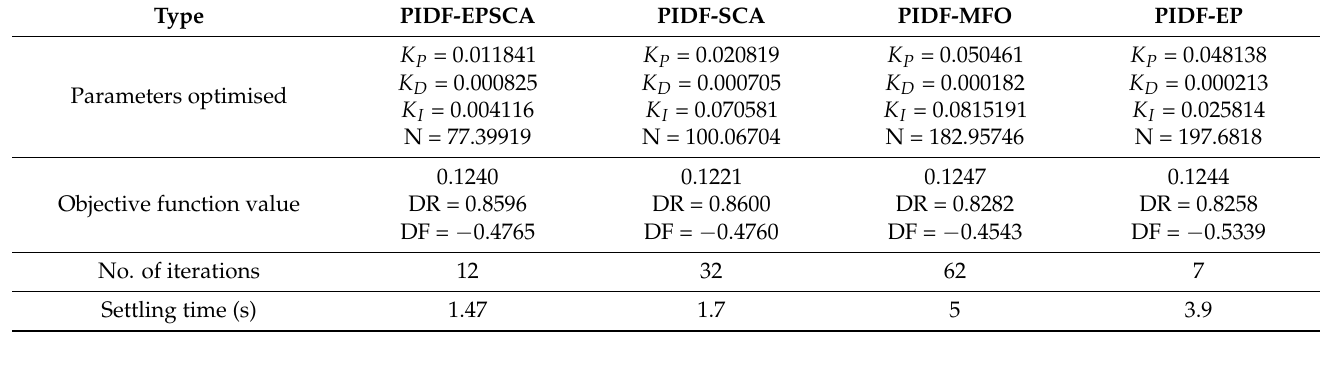
Table 5. Comparison of PIDF-EPSCA, PIDF-SCA, PIDF-MFO, and PIDF-EP for Scenario A-3.